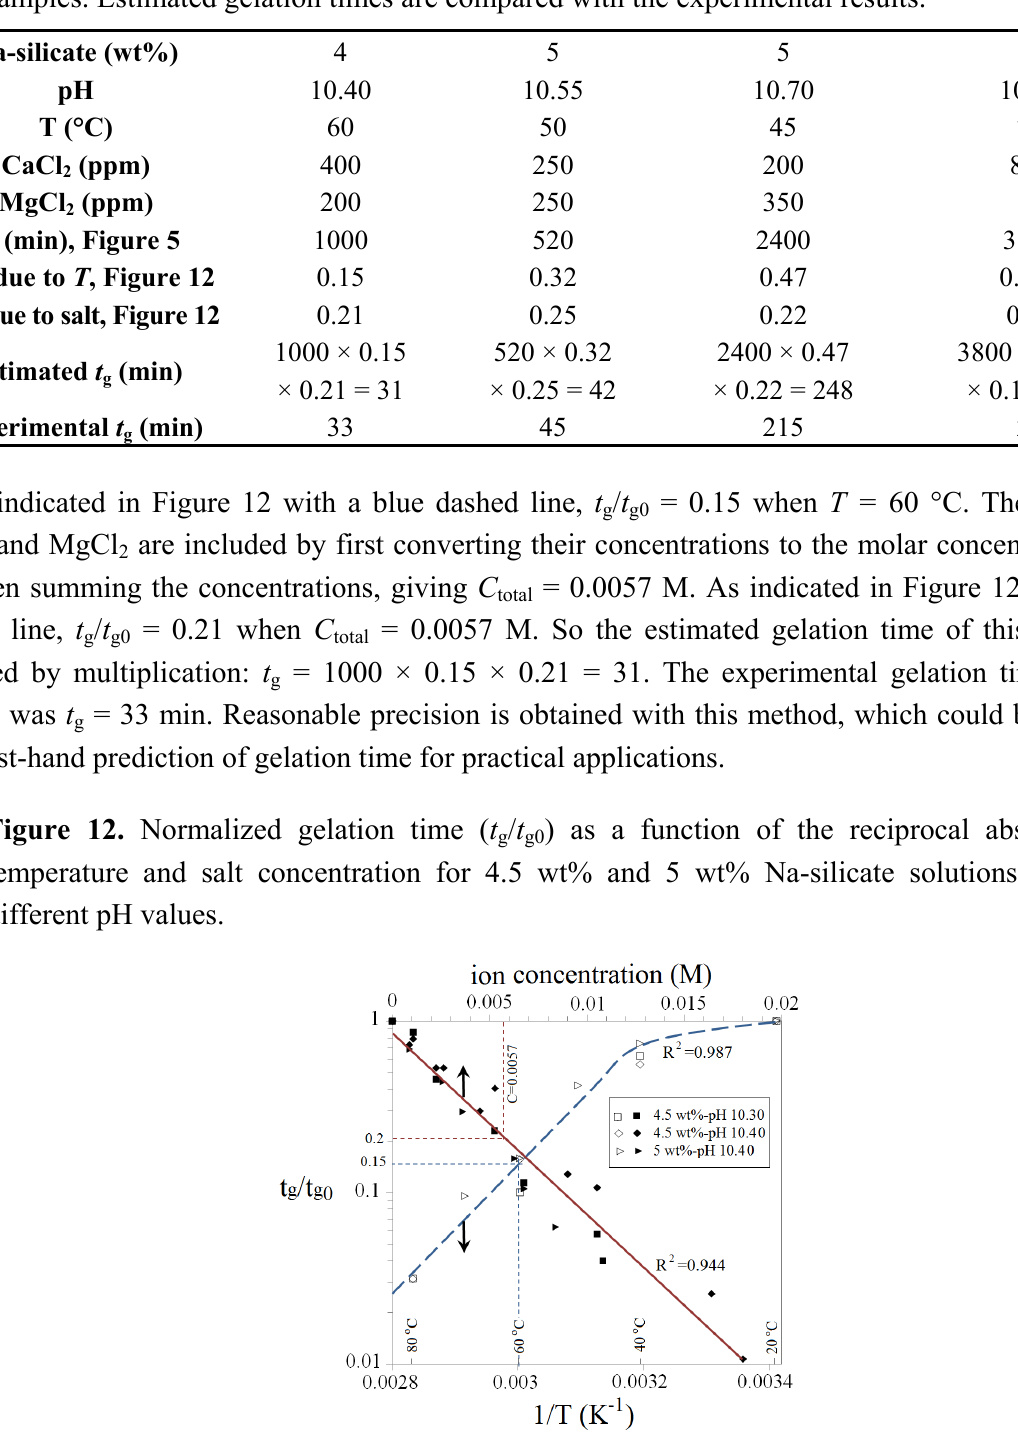
Table 2. Summarized method for estimating gelation time applied to four different Na-silicate samples. Estimated gelation times are compared with the experimental results.